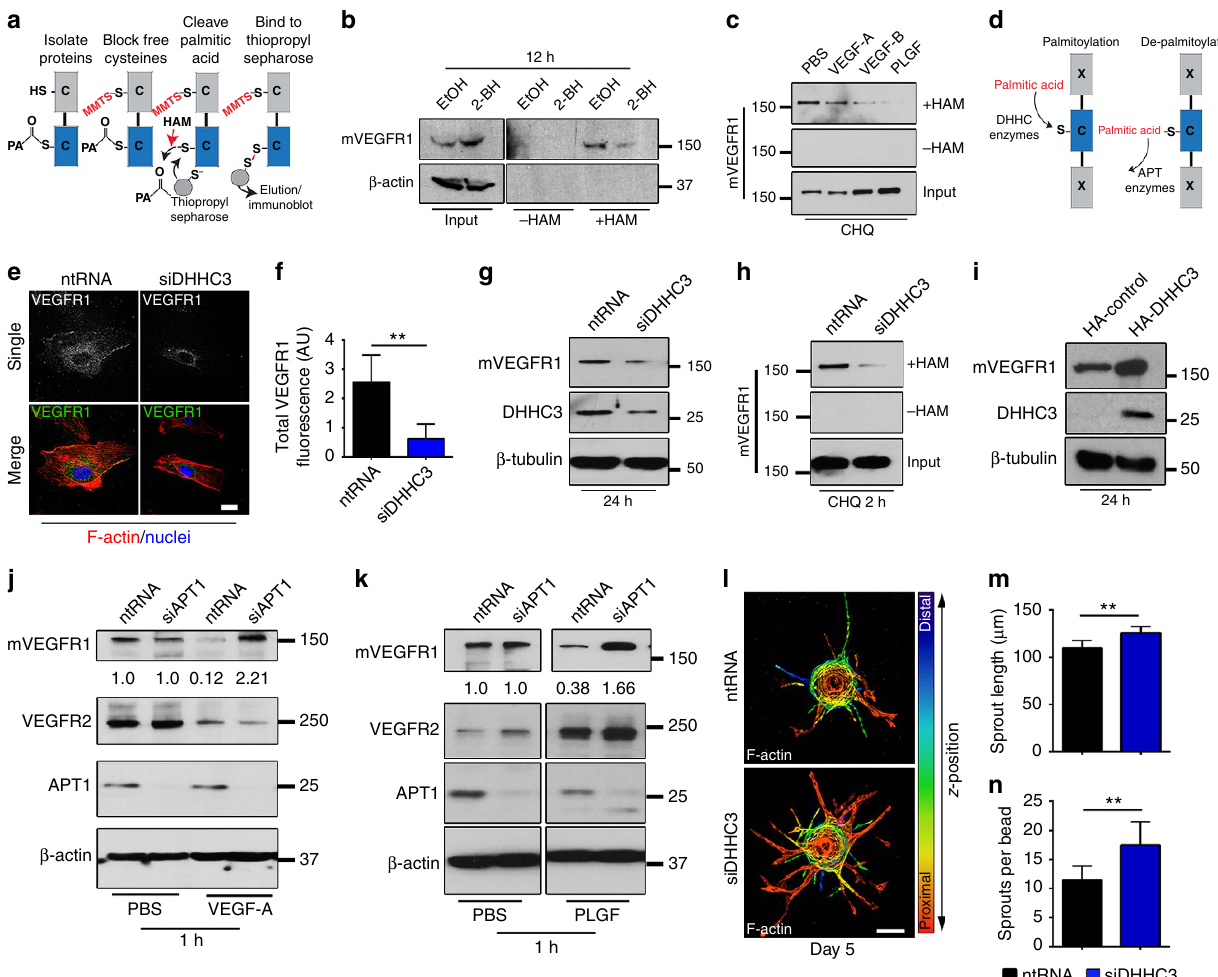
Figure 4 | VEGFR1 is palmitoylated in endothelial cells to regulate turnover. ( a ) Workflow for acyl-resin assisted capture (Acyl-RAC). PA, palmitic acid; MMTS, methyl-methanethiosulfonate. ( b ) Acyl-RAC and immunoblot of HUVEC with indicated treatments. 2-BH, 2-bromohexadecadnoic acid; three replicates. ( c ) Acyl-RAC and immunoblot of VEGFR1 from HUVEC with indicated treatments for 45min. CHQ, chloroquine; three replicates. ( d ) Diagram illustrating palmitic acid addition and removal. DHHC, protein acetyl-transferase; APT, acyl-protein thioesterase. ( e , f ) ( e ) VEGFR1 immunofluorescence of HUVEC with indicated treatments for 24h, scale bar: 25 m m. ( f ) Quantification of fluorescence via integrated density. Shown are means þ 95% CI. (No. of cells: ntRNA, n ¼ 21; siDHHC3, n ¼ 22); four replicates. ( g ) Immunoblot of mVEGFR1 from HUVEC with indicated treatments; three replicates. ( h ) Acyl-RAC and immunoblot of HUVEC with indicated treatments for 24h; three replicates. ( i ) Immunoblot of VEGFR1 and HA-tagged DHHC3 in HUVEC with indicated treatments for 24h; three replicates. ( j , k ) Immunoblot of HUVEC with indicated treatments at 48h post knockdown and treated with 50ngml (cid:2) 1 VEGF-A ( j ) or PLGF ( k ); three replicates. ( l – n ) ( l ) HUVEC angiogenic sprouts with indicated treatments, scale bar: 100 m m. ( m , n ) Quantification of angiogenic parameters. (sprouts per bead no. of beads: ntRNA, n ¼ 25; siDHHC3, n ¼ 27; sprout length, no. of sprouts: ntRNA, n ¼ 288; siDHHC3, n ¼ 365); two replicates. Statistics: Students t -test and post-hoc Tukey’s range test. ** P r